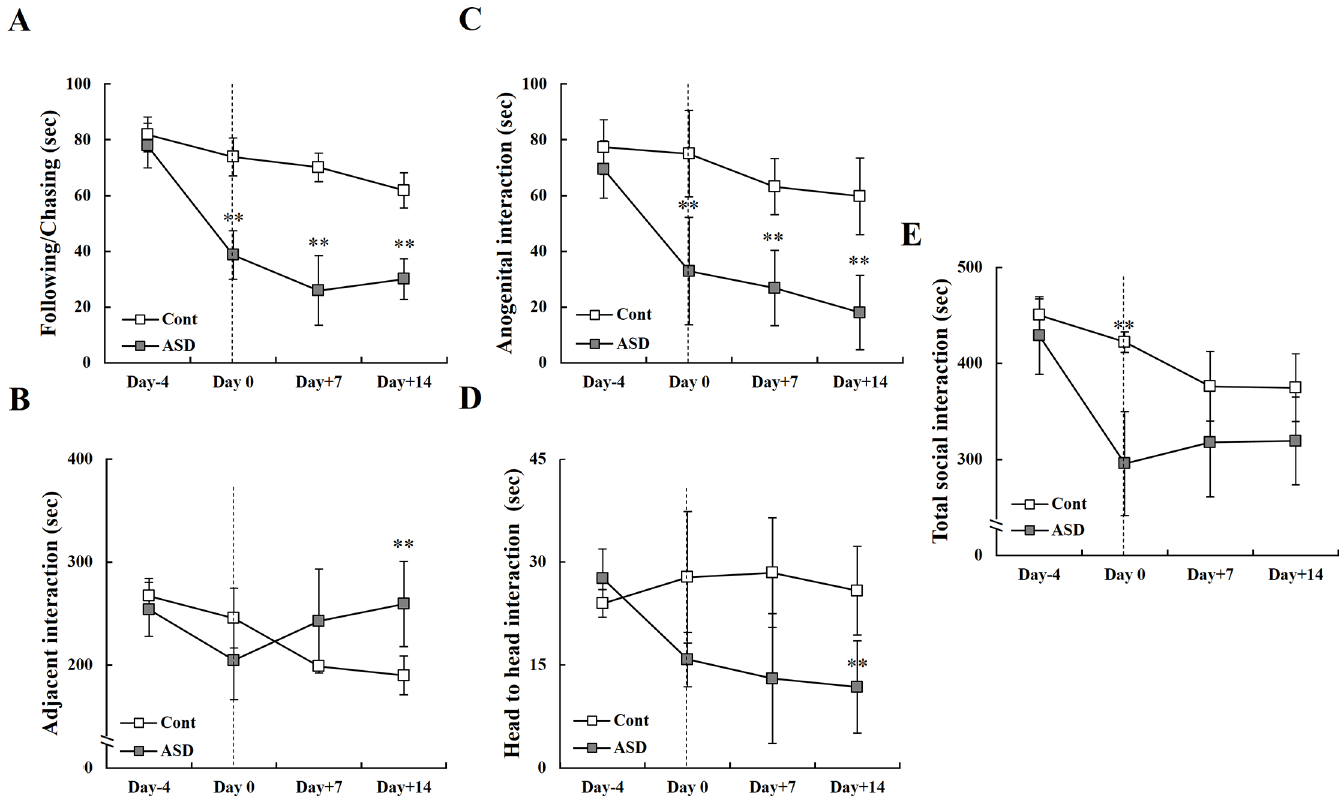
Fig 4. Alterations in social interaction between early and late post-induction day following PPA administration. (A, C, D) PPA-treated rats showed significantly reduced non-aggressive behavior, but (B) increased aggressive behavior during the late PID period (days 7 and 14). (E) All social interactions between the control and PPA-treated rats are shown. Data are presented as the mean ± SD. Cont, control rats; ASD, PPA-treated rats. (cid:3) p < 0.01: vs . Cont.